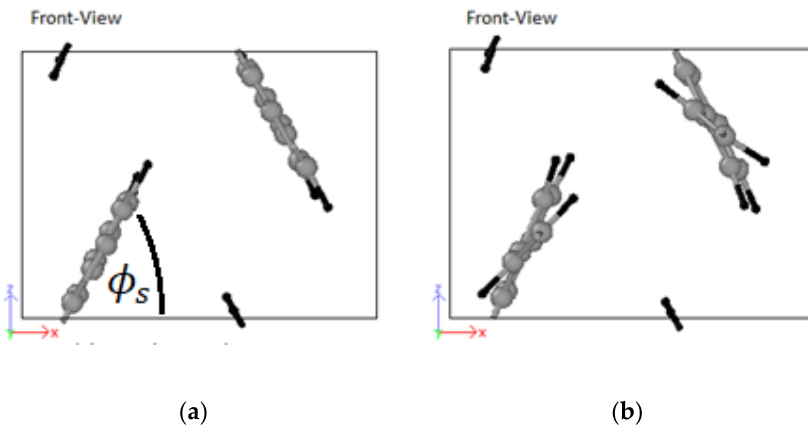
Figure 4. ( a ) PPV molecule with minimal rotation of vinyl link using B3LYP / 6-31 + G* / AMBER; ( b ) PPV molecule using universal force field (UFF).